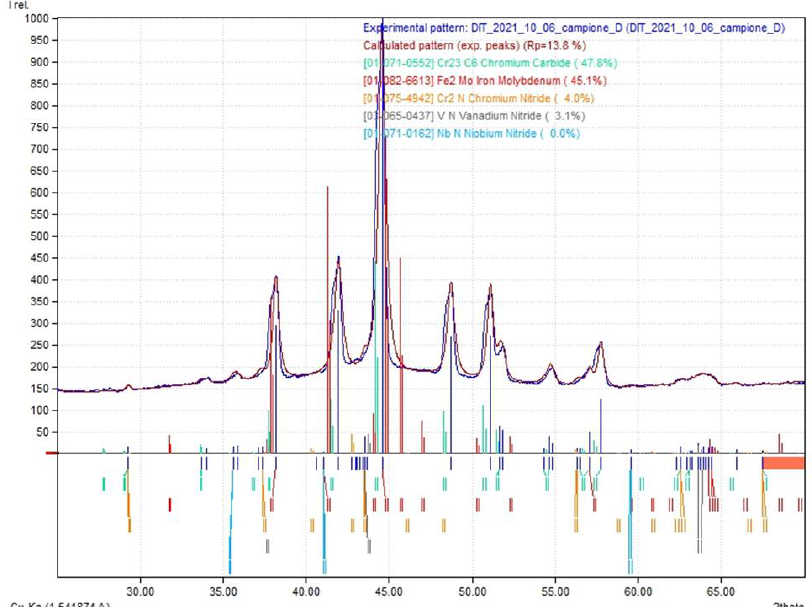
Figure 10. Failed crept cross-weld specimen 91-HAZ-3-8 650 °C 61 MPa 2072 h (sample D).